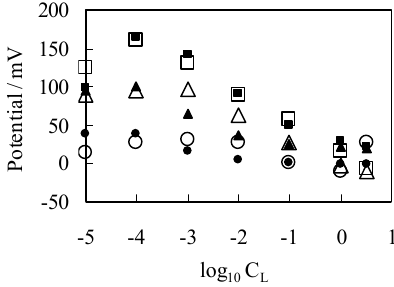
Figure 7. Potential generated between two KCl solutions using a separator of GC1 (GC2, C (=log [K + ] ), where offset potentials are added to some data for GC3) vs. log 10 L 10 L decongesting the diagram. Open and closed marks represent the experimental and computational potentials, respectively. Circle marks: in case a GC1 used Triangle marks: in case a GC2 separator used (+25 mV offset potential is added to the actual data) Square marks: in case a GC3 separator used (+50 mV offset potential is added to the actual